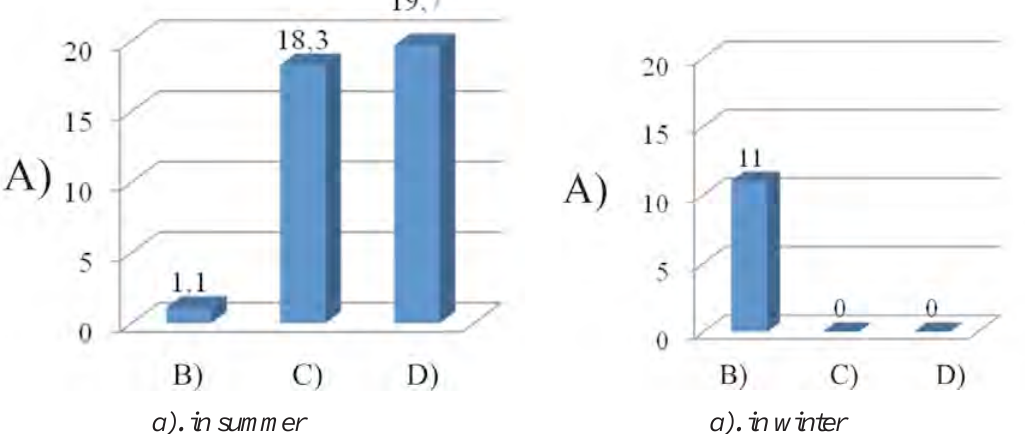
Fig. 3. Exceeding the temperature sensor in the air of the cab passenger route buses during the change: A) - Temperature, 0 С; B) - Beginning; C) - Middle; D) -